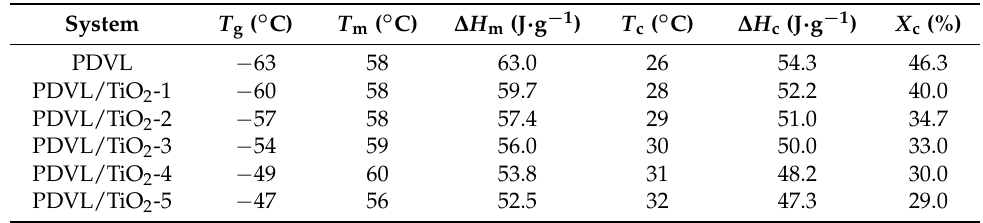
Table 2. Glass transition temperatures and melting points of pure PDVL and PDVL/TiO 2 composites obtained at a heating rate of 20 °C·min − 1 .